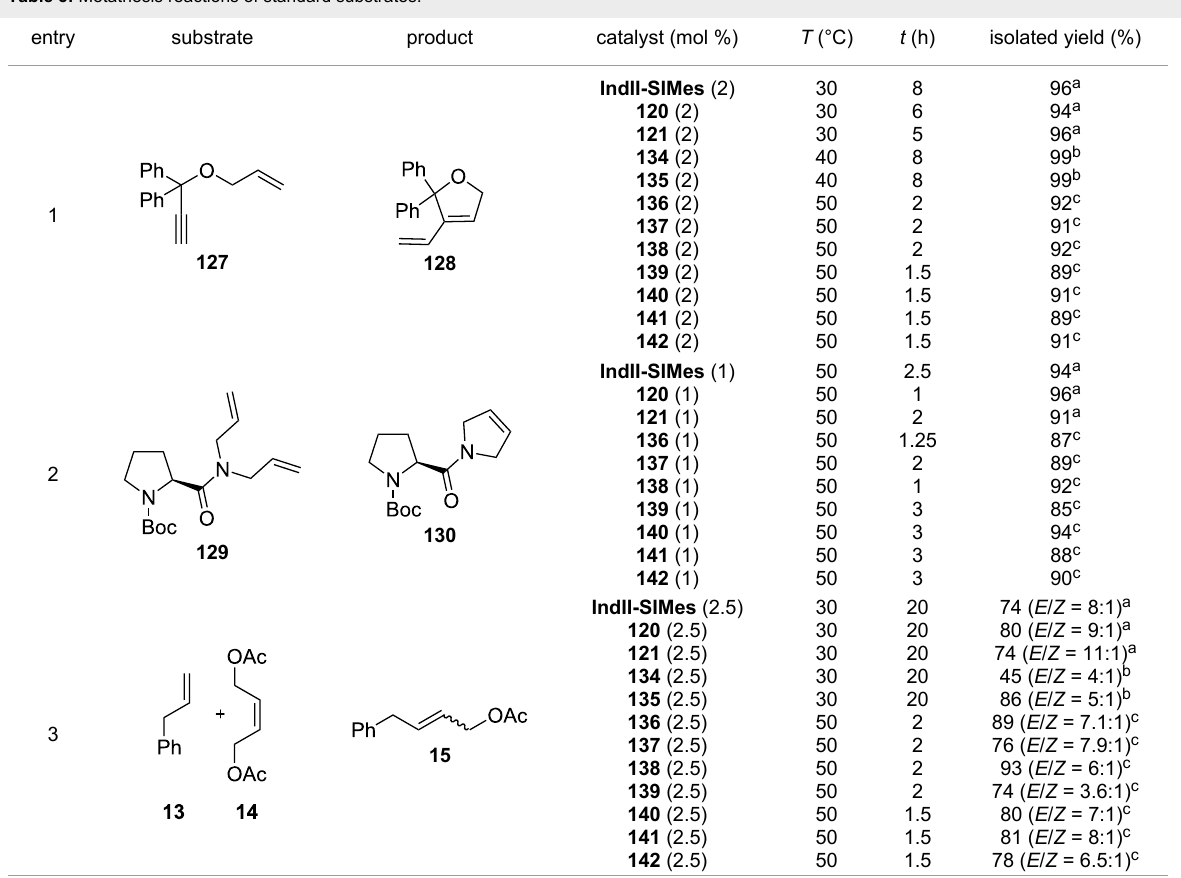
Table 5: Metathesis reactions of standard